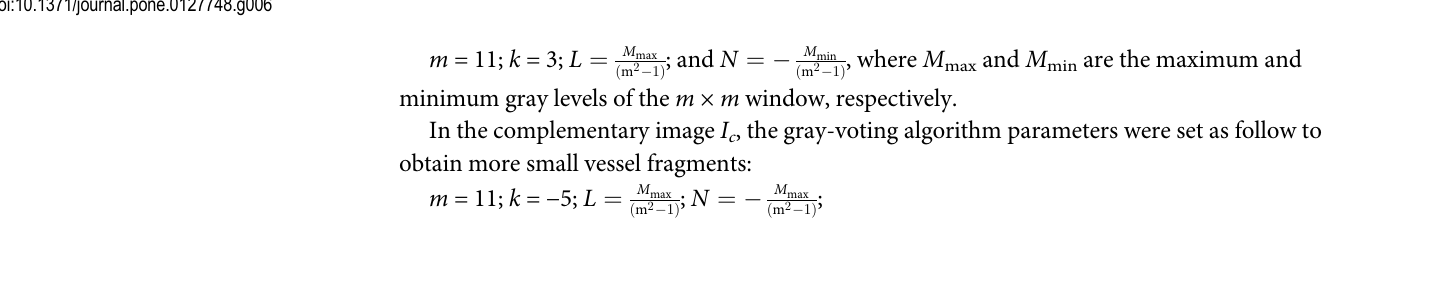
PLOS ONE | DOI:10.1371/journal.pone.0127748 June 5,